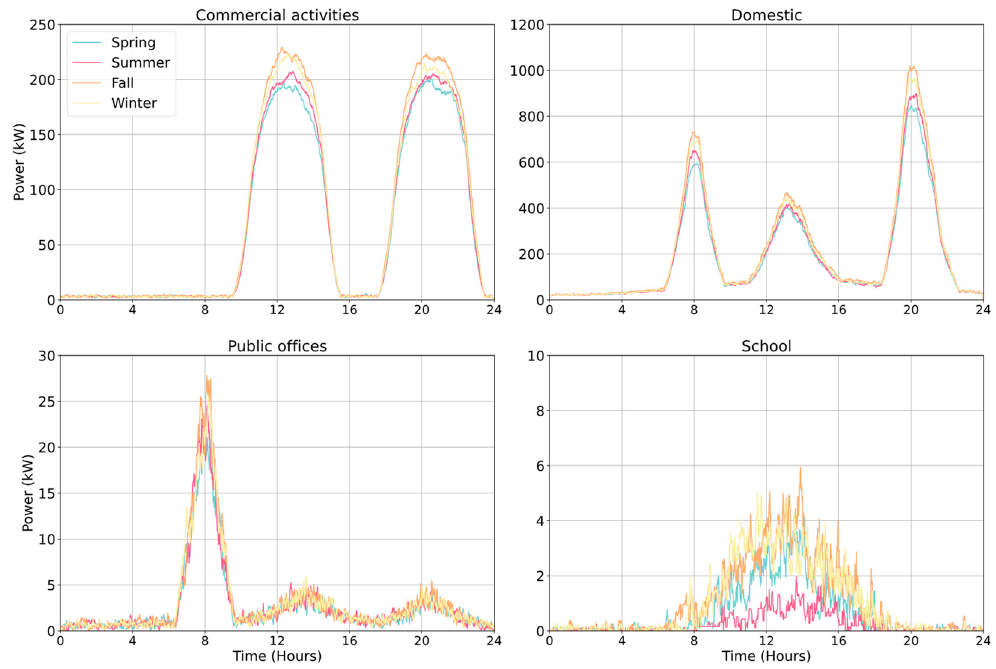
Figure 5. Thermal load profiles for the four user classes: ( top right ) domestic; ( top left ) commercial activities; ( bottom left ) public offices; and ( bottom right ) school.